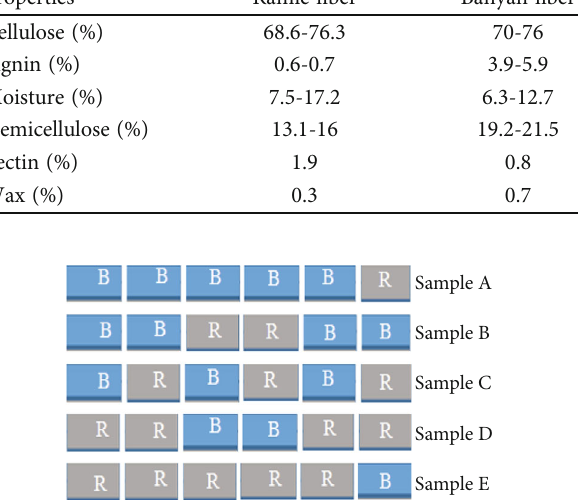
Figure 1: The stacking sequence of hybrid